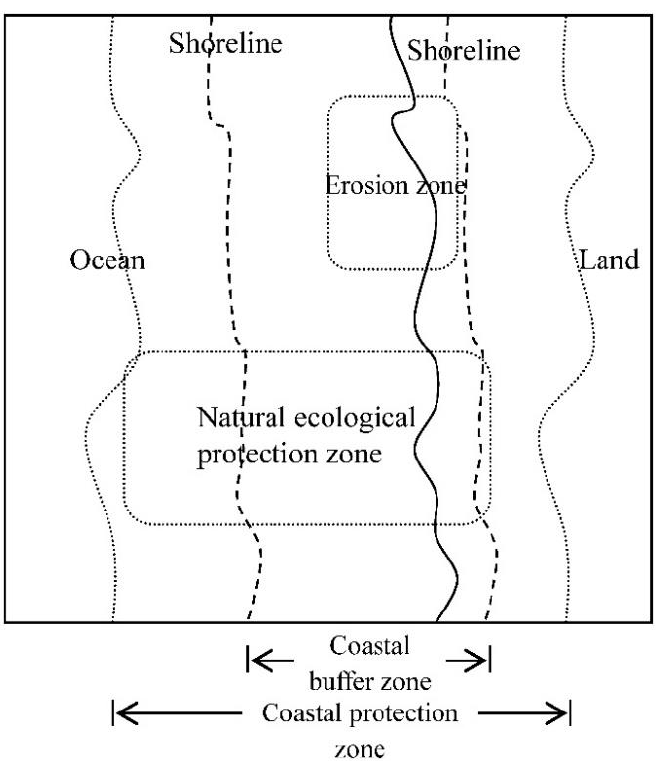
Figure 3. Sketch of coastal buffer and protection zones. In Taiwan, the designation of coastal protection and buffer zones is based on typhoon waves and their resultant storm surges during a return period of 50 years as the input conditions. The suitability of the designated area is reviewed every ten